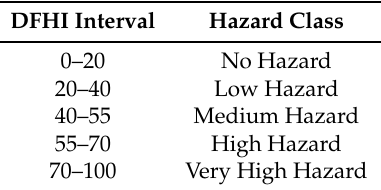
Table 3. DFHI Hazard